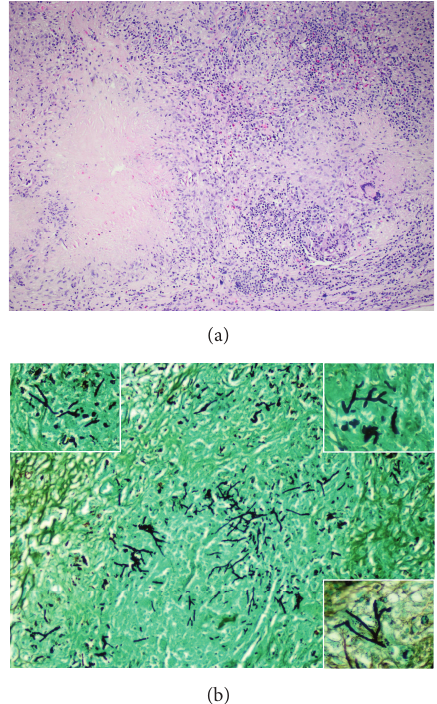
Figure 1: Excisional biopsy material of the cervical lymph node: (a) hematoxylin and eosin and (b), Gomori methenamine silver stain; caseation necrosis and giant cell granulomas with several fungus hyphae, they were morphologically branching hyphae with right/acute